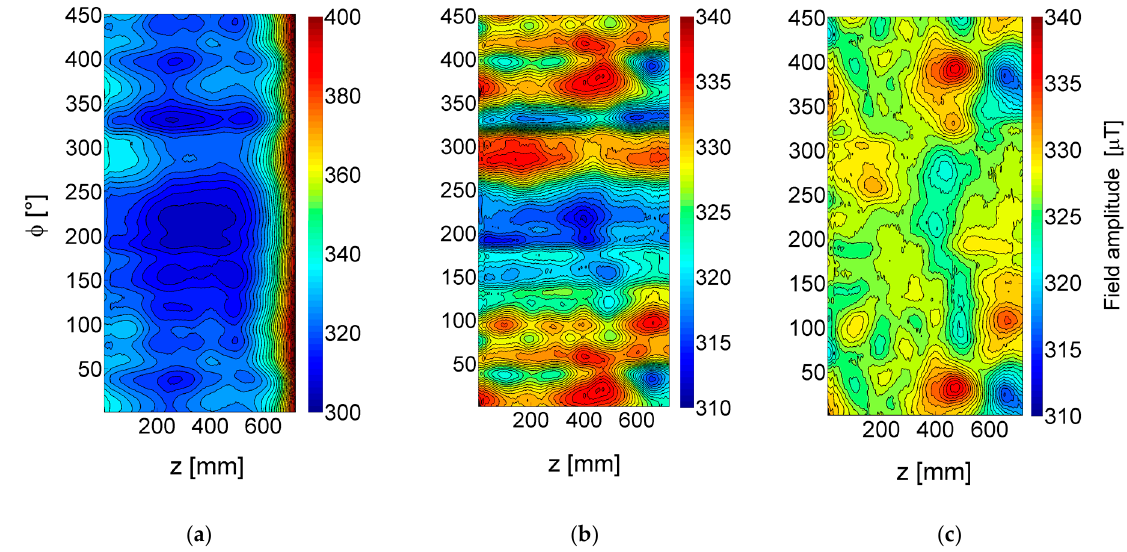
Figure 4. ( a ) Magnetic field amplitude over the surface of bare pipe ( r -sensor); ( b ) same plot after applying algorithms to correct for changes in excitation current and effects at the end of the pipe; ( c ) same plot after applying an additional correction algorithm.